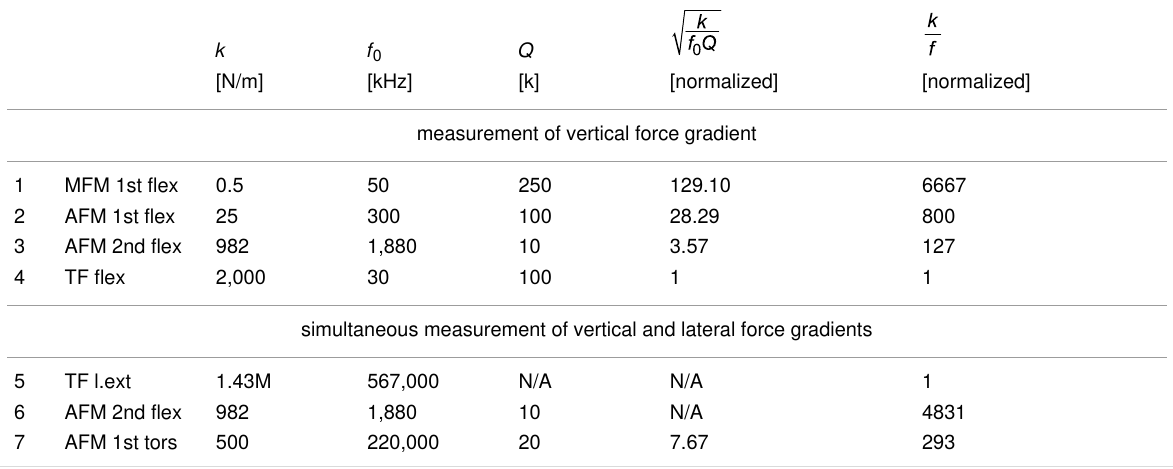
Table 1: Thermal and detector noise sensitivities of different cantilevers and oscillation modes normalized to that of a tuning fork operated at the same temperature (TF in the table) sensor (higher numbers, i.e., higher measurement sensitivities are better). Line 1: High-quality factor MFM cantile- ver operated under vacuum conditions [29] in its first flexural mode. Lines 2 and 3: Typical cantilever used for atomic resolution work, operated in the first and second flexural mode, respectively. Line 4: Tuning fork sensor [13] operated in its flexural mode for comparison with lines 1–3. Line 5: For bi-axial force gradient measurements with a tuning fork [65], its length extension mode was used to map the vertical force gradient. Line 6: The canti- lever with the properties given in line 3 now compared to the sensitivity of the tuning fork length extension mode given in line 5. Line 7: Lateral force sensitivity obtained with the first torsional oscillation mode of a cantilever (that can be measured simultaneously with its second flexural mode, line 3), which needs to be compared to the sensitivity of the tuning fork operated in its conventional flexural mode (line 4).